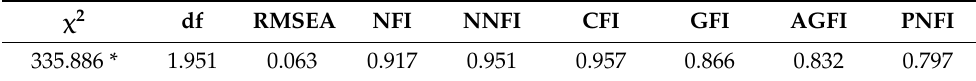
Table 6. Goodness of fit of the structural model.